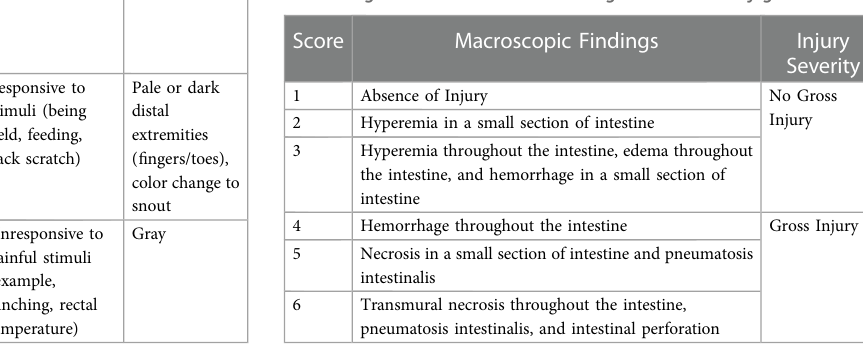
TABLE 2 Gross injury scoring system. Gross injury scores were assigned to the proximal small intestine, mid small intestine, distal small intestine, and colon of each animal. Scores of 1 – 3 were considered to have no gross injury, and scores of 4 – 6 were considered to have gross injury. The fi nal score assigned to an animal was the highest score in any given